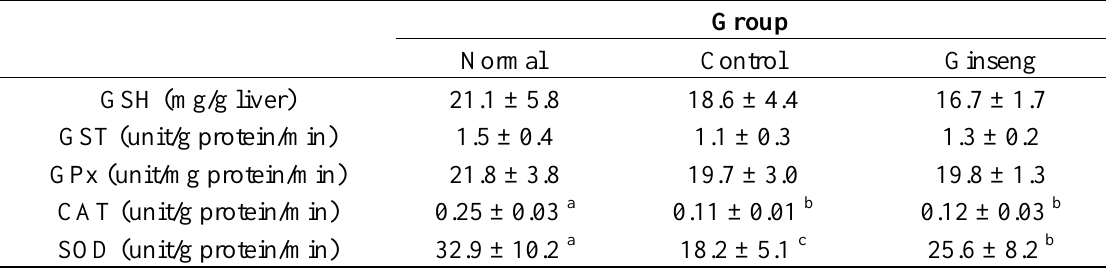
Table 3. Glutathione contents and hepatic antioxidant enzyme activities in the rabbits fed the experimental